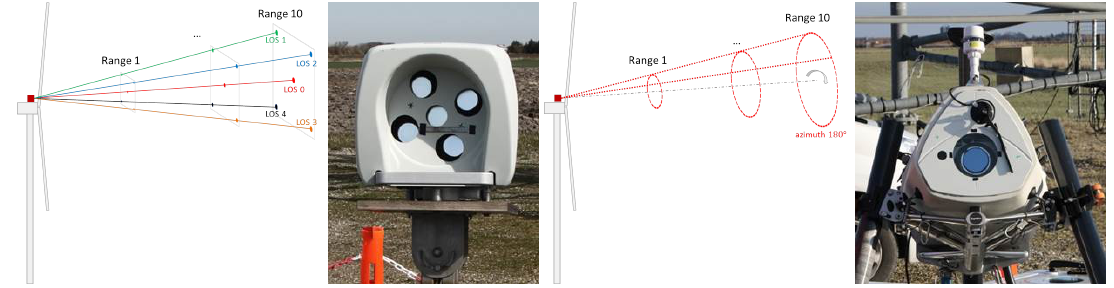
Figure 1. Two wind profiling nacelle lidar examples: 5-beam Avent Demonstrator ( left ) and Zephir Dual-Mode ( right